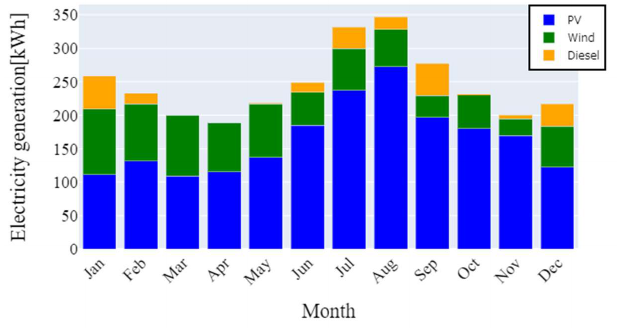
Figure 22. Monthly average electricity generation by the microgrid.